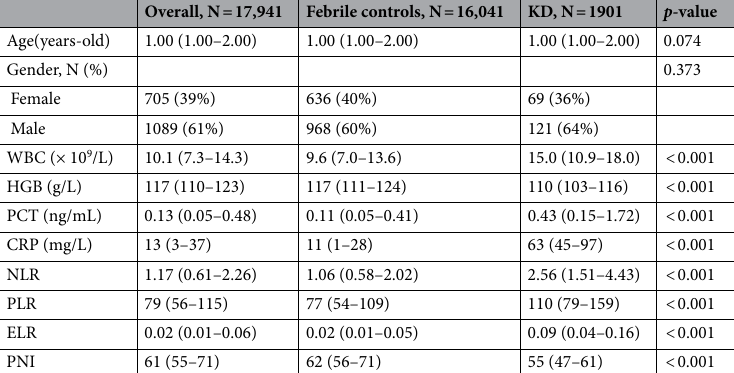
Table 1. Phenotype of study subjects between the KD and the febrile